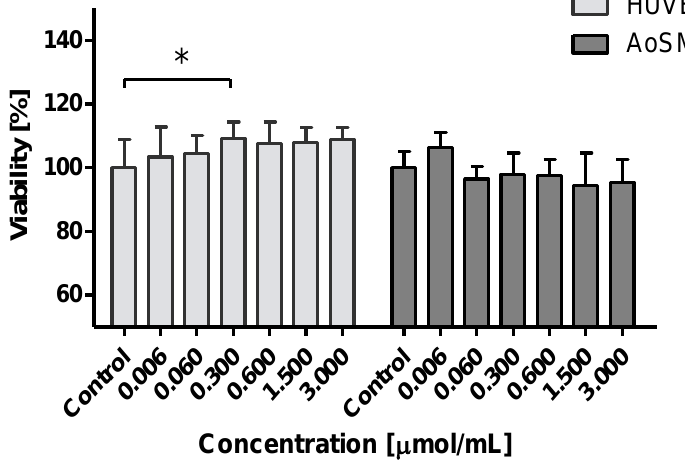
Figure 2. The effects of metformin on the viability of HUVEC and AoSMC cells. The cells were incubated with metformin at concentrations 0.006–3.000 μmol/mL for 24 h, and the viability of the cells was measured spectrophotometrically using the WST-1 test. The results are presented as mean ± SD, n = 8. One-way Anova analysis revealed significant differences in HUVEC viability only for metformin at 0.300 µmol/mL (* p < 0.05). In the case of AoSMC cells the analysis did not show any differences between control samples and metformin over the entire concentration range.